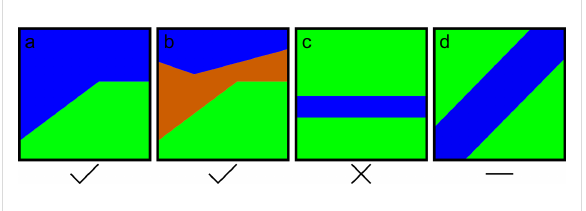
Figure 2: Illustrated cases of overlapping crystallites in cross section (different colors represent different crystal orientations).